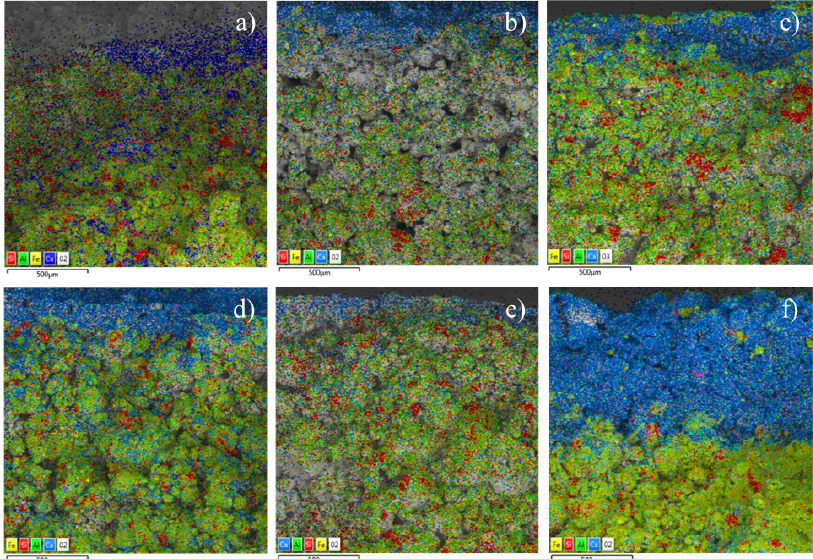
Figure 4. SEM micrographs with EDS analysis of treated soil–lime: ( a ) soil + 1% lime, 7 days; ( b ) soil + 2% lime, 7 days; ( c ) soil + 4% lime, 7 days; ( d ) soil + 1% lime, 56 days; ( e ) soil + 2% lime, 56 days; ( f ) soil + 4% lime, 56 days. Meaning of colours: green = aluminium; blue = calcium; red = silicon; yellow = iron; white = no data.